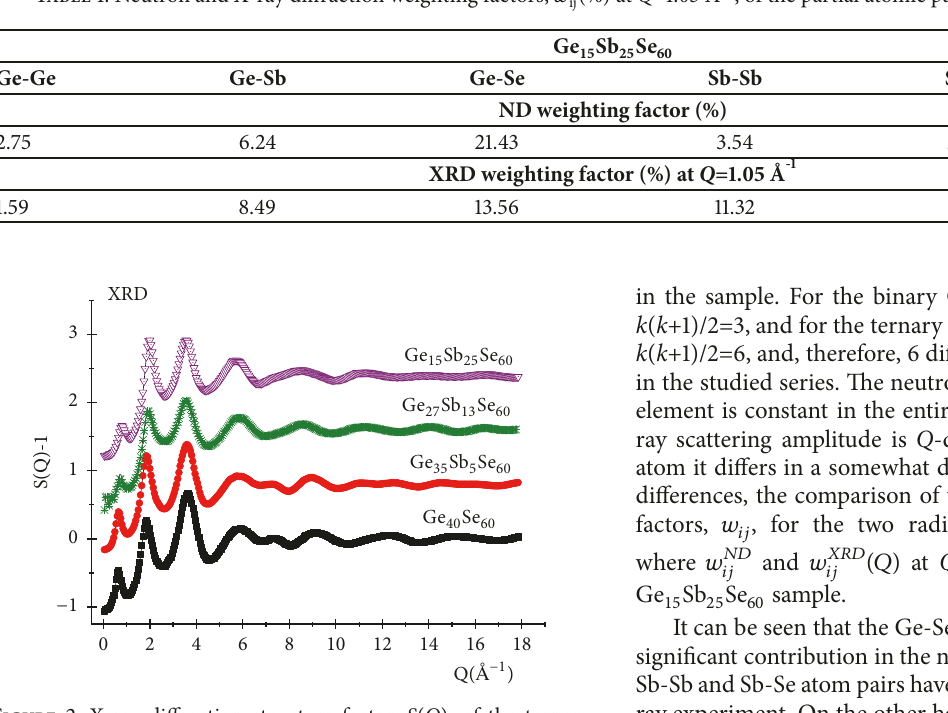
Table 1: Neutron and X-ray diffraction weighting factors, 𝑤 ij (%) at Q =1.05 ˚A -